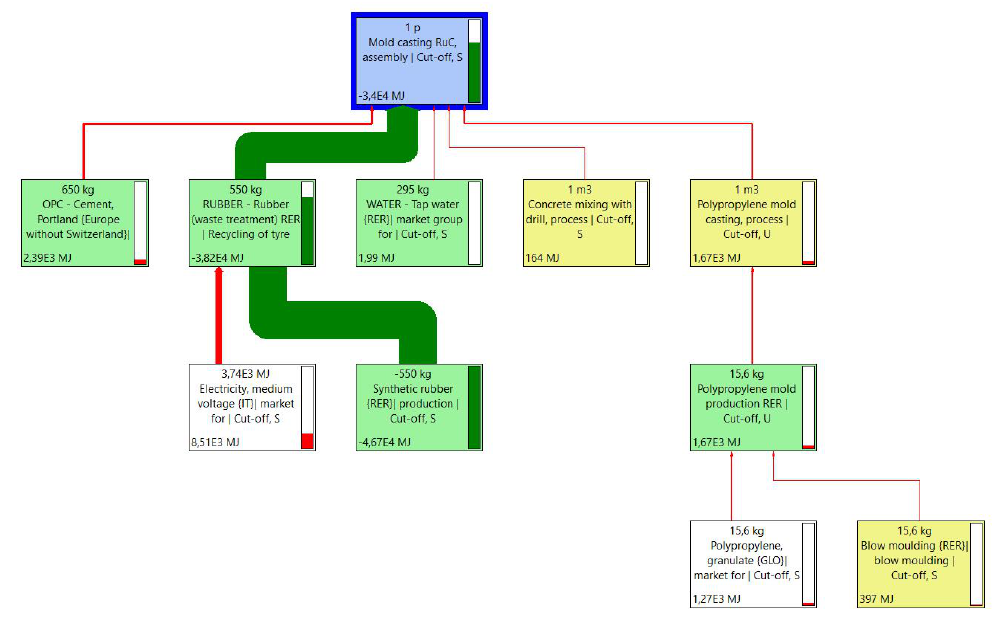
Figure A7. SimaPro CED network for p-RuC mix processing.